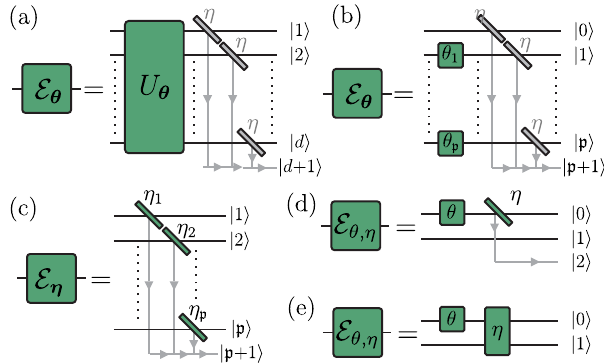
FIG. 3. Schematic representation of the tasks considered in this section: simultaneous estimation of (a) the parameters of an arbitrary U ð d Þ transformation with erasure noise; (b) multiple phases in the presence of uniform loss on all modes; (c) multiples losses; (d) phase and loss imprinted by a sample in a two-arm interferometer; (e) phase and dephasing in a two-arm interfer-